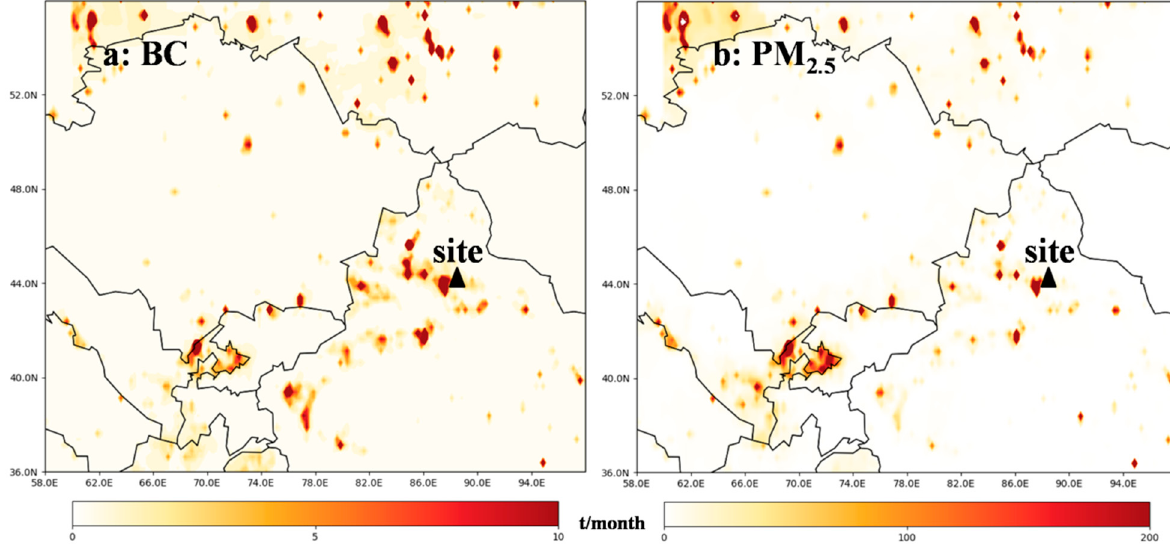
Figure 10. Distributions of ( a ) BC and ( b ) PM 2.5 from the MIX emission inventory.